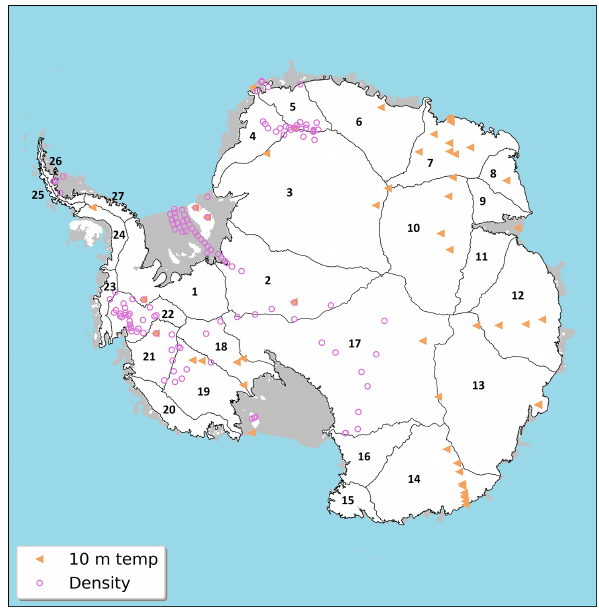
Figure 4. The white colour shows the GAIS, and the grey colours show the locations of ice shelves. The spatial distribution of obser- vations are shown with light brown triangles for borehole temper- atures and magenta circles for the location of the density profiles. The grounded basins are derived from Zwally et al. (2012) and out- lined by black lines. Table 3. Mean difference between the modelled and observed firn densities (model – core) and standard deviation of the modelled den- sities above and below 550kgm − 3 . In total 139 cores were used; see Fig. 4 for